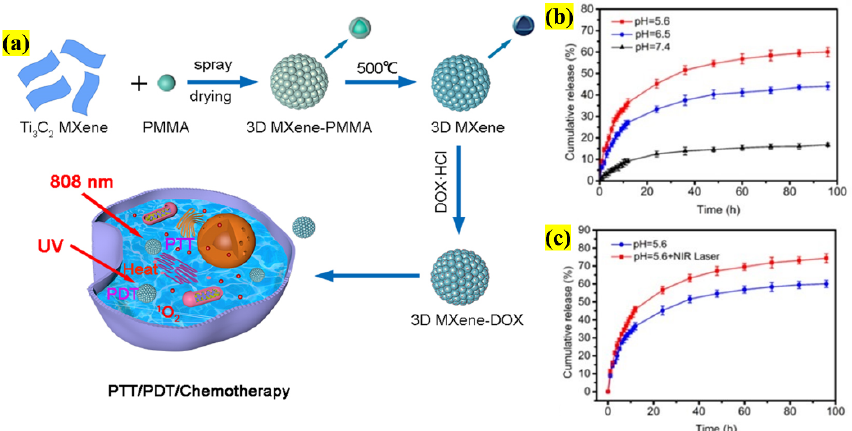
Figure 4. Schematic illustration representing ( a ) the fabrication of a 3D NS microsphere using PMMA and loading with DOX for synergistic CTX/PTT/PDT treatment of a tumor; ( b ) cumulative drug liberation at various pH values; ( c ) DOX release after NIR irradiation (adapted with permission from Reference [26] (2021) © IOP Publishing. All rights reserved).